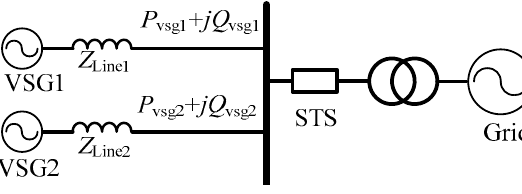
Figure 8. Microgrid simulation platform.